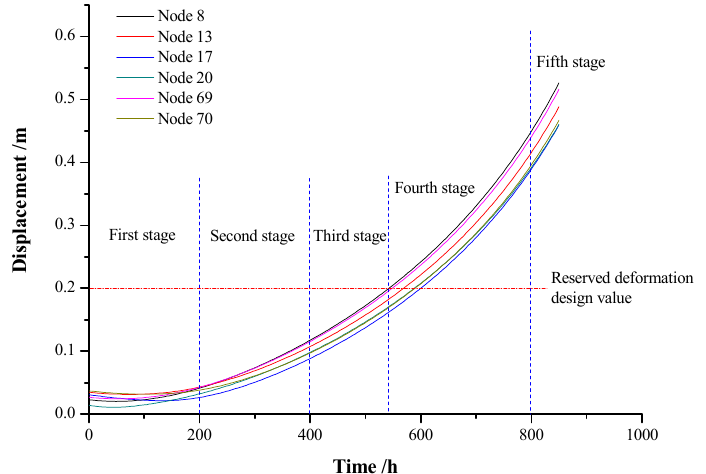
Figure 16. Variation curve of the displacements of tunnel measuring points with time.